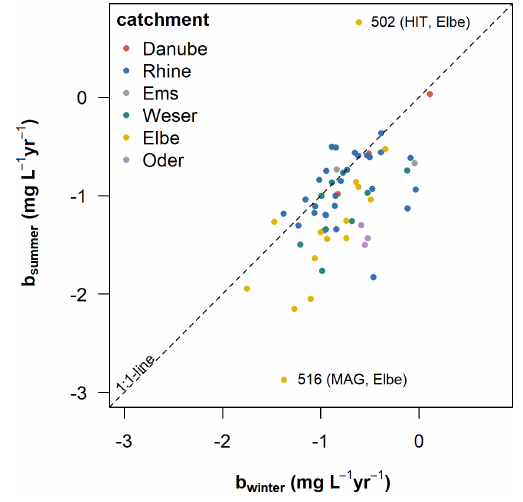
Figure 6. Scatterplot of Sen’s slope for winter and summer